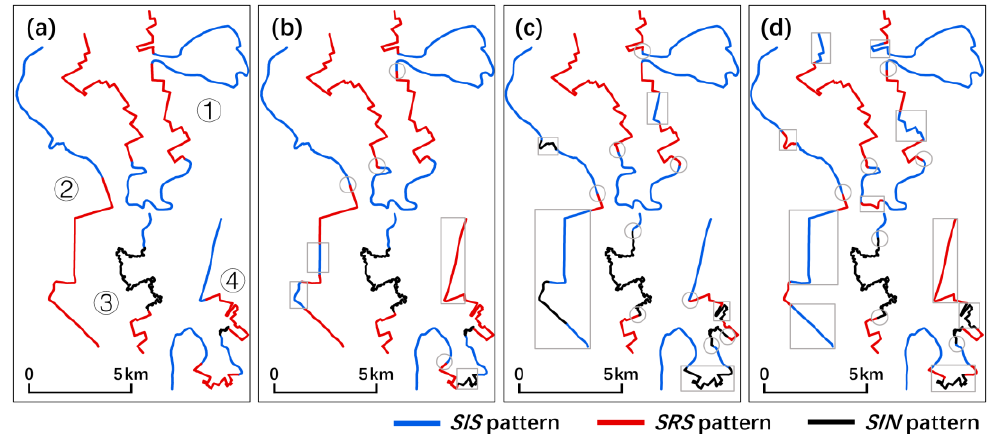
Figure 14. Segmentation results for four typical test boundaries (numbered 1–4) using different methods: ( a ) manual identification, ( b ) 1D-U-Net, ( c ) BANN method, and ( d ) NB method. Boxes highlight incorrect classifications and circles mark deviations in the segmentation points.